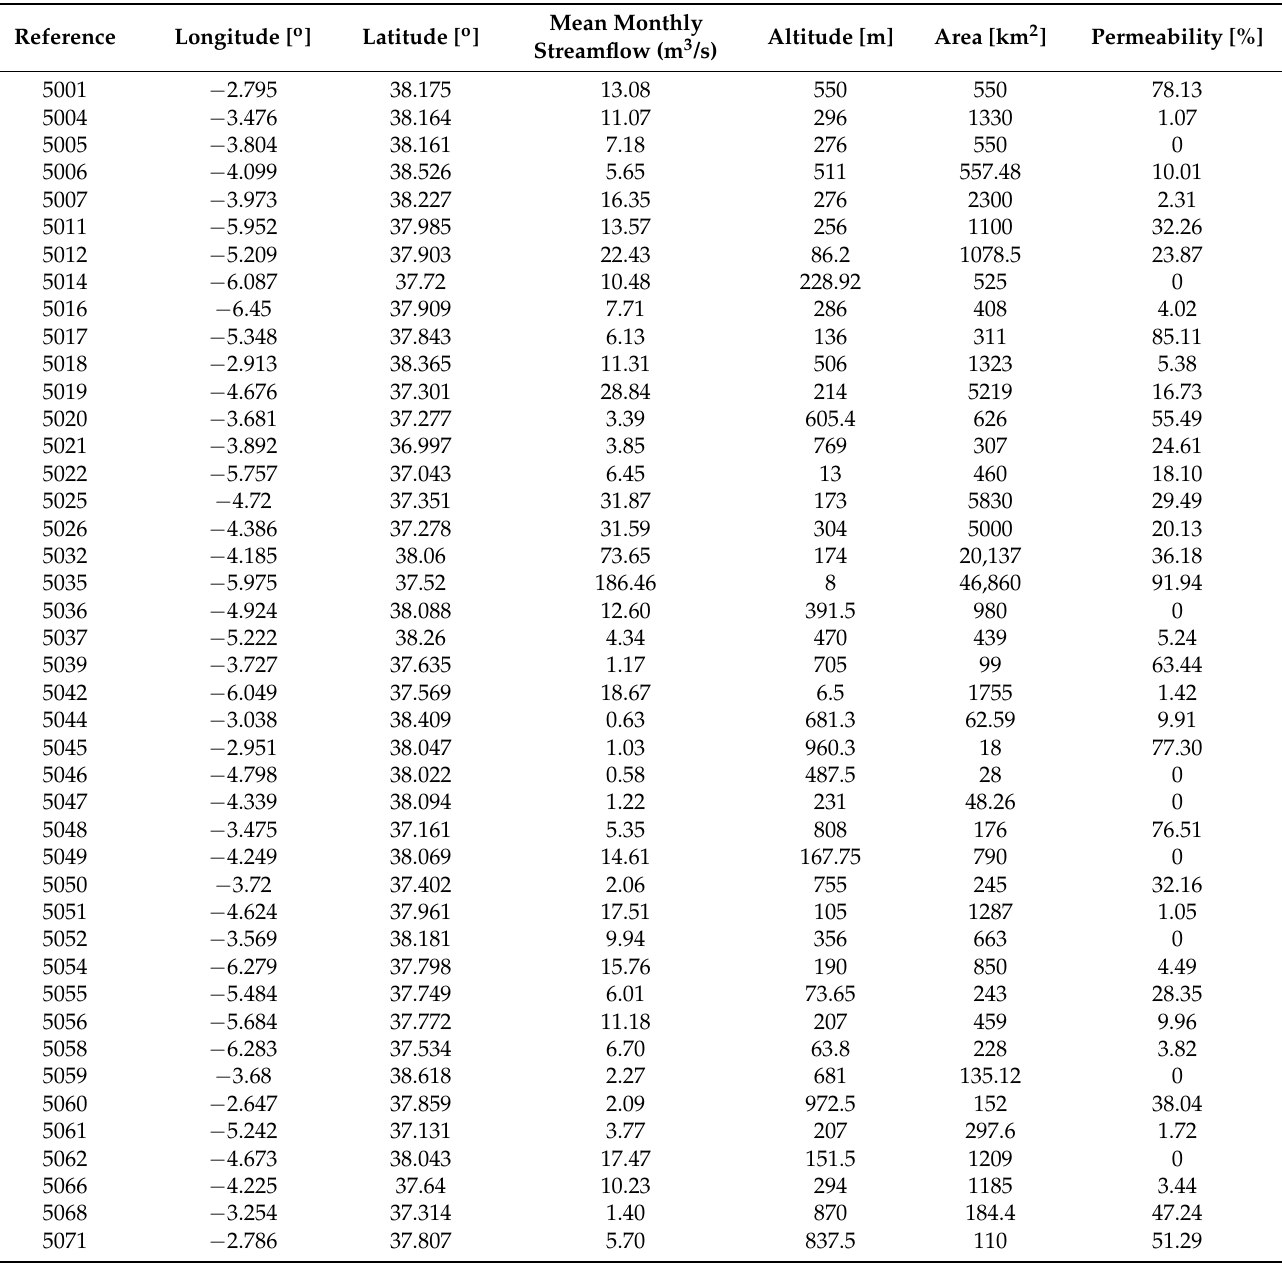
Table 1. Characteristics of reservoir stations used in this